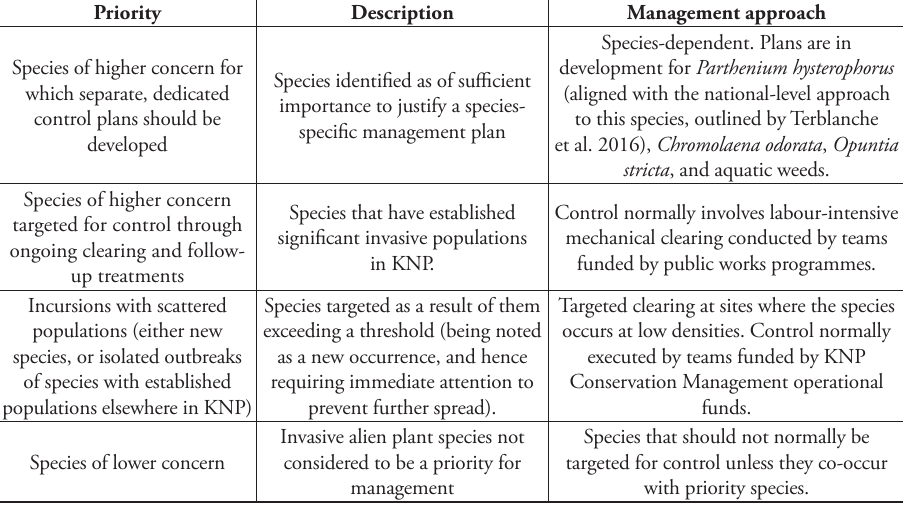
Table 1. Priorities assigned to invasive alien plant species in the Kruger National